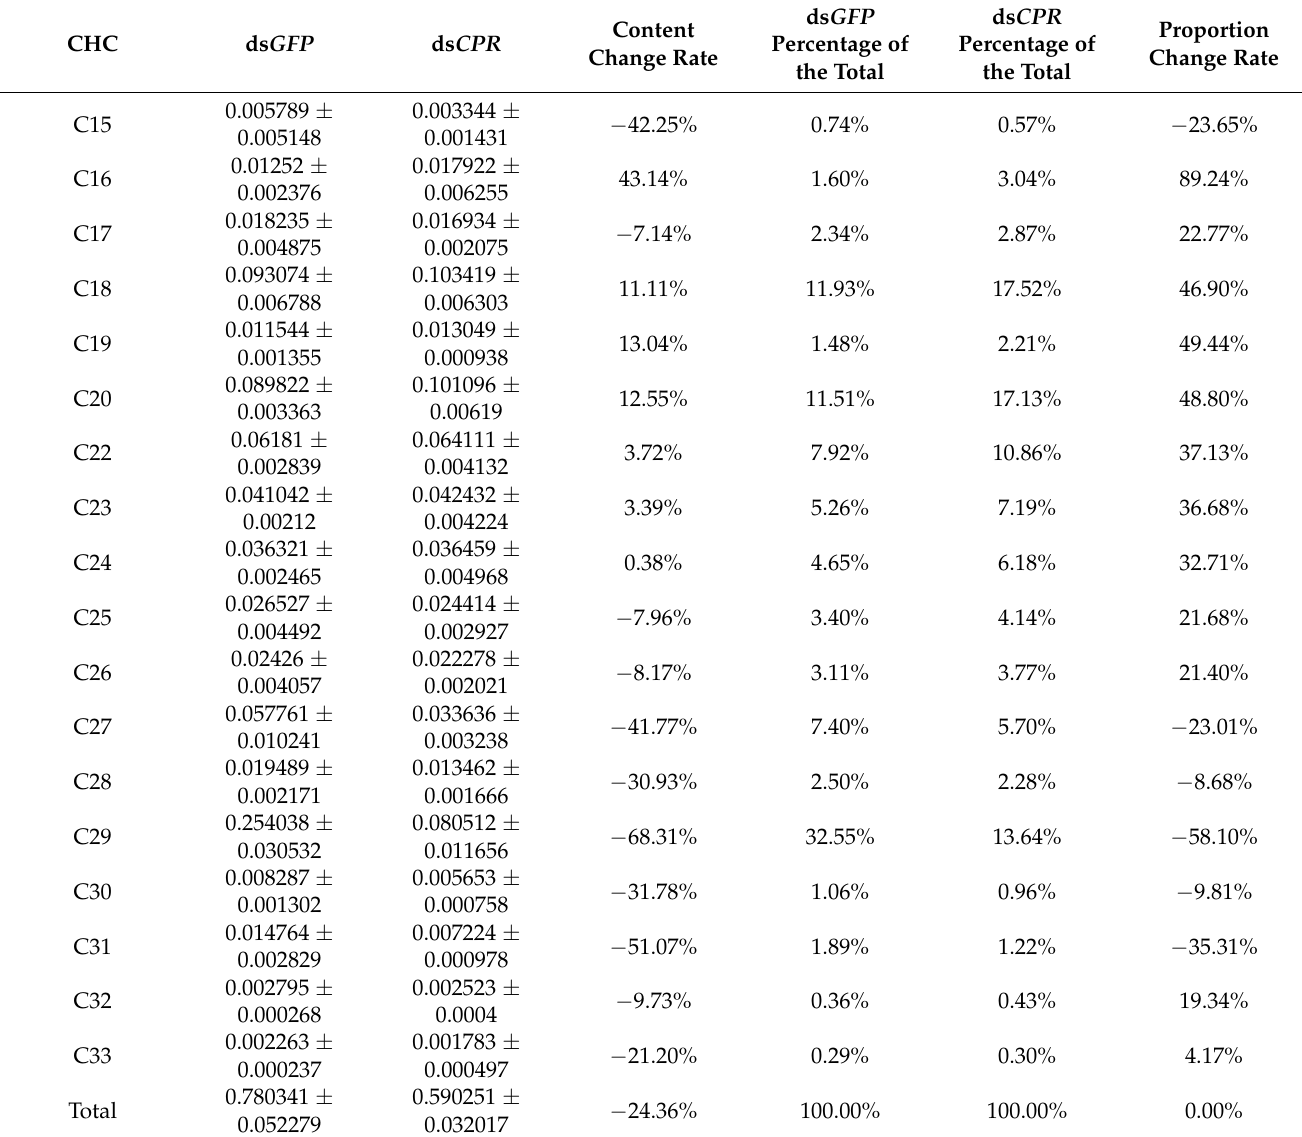
Table 1. CHC profile of N. lugens female